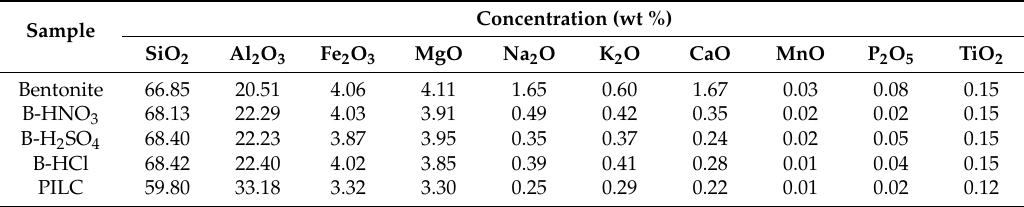
Table 1. Chemical analysis, estimated by XRF, of the raw bentonite, bentonite modified by acid treatment and PILC (wt %).